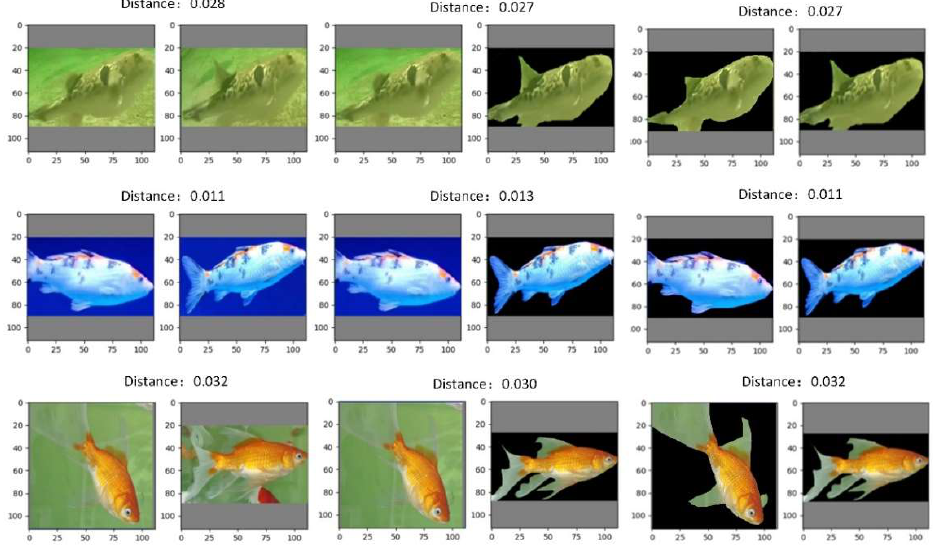
Figure 16. Experimental results of different background environments.